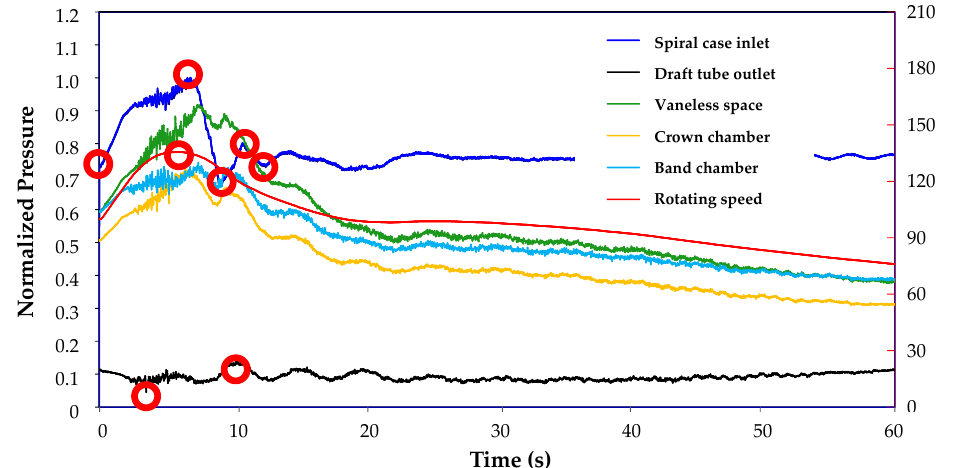
Figure 3. The measured parameters of the pump-turbine unit during load rejection. As marked with red circles in Figure 3, eight moments at the extreme values of the measured data in the first 12 s during the load rejection of the PT unit were selected for 3D flow simulations (Table 2). After 12 s in the load rejection process, the PT unit slowed down, and the flow changes were not as drastic as before. The measured pressure values of the spiral case inlet and the draft tube outlet, rotating speed and guide vane opening at different moments were used to set up the boundary conditions and initial conditions of the CFD analysis. Table 2. Parameters of boundary conditions and initial conditions of the CFD